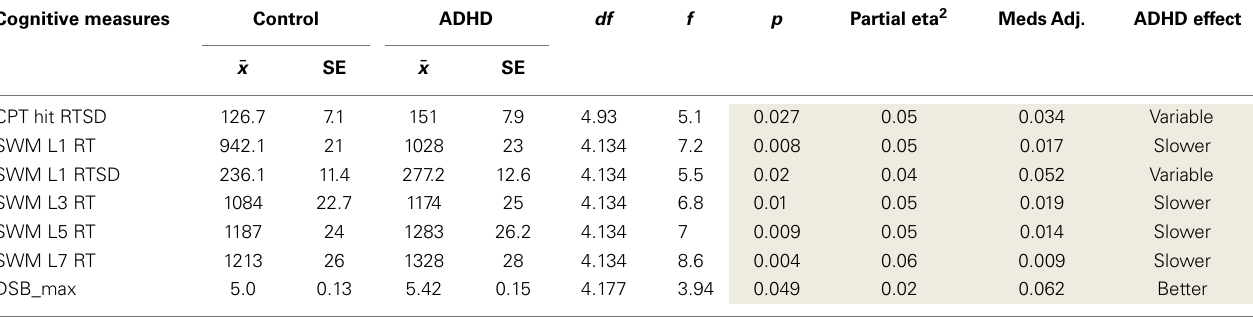
Table 8 | Cognitive effects .